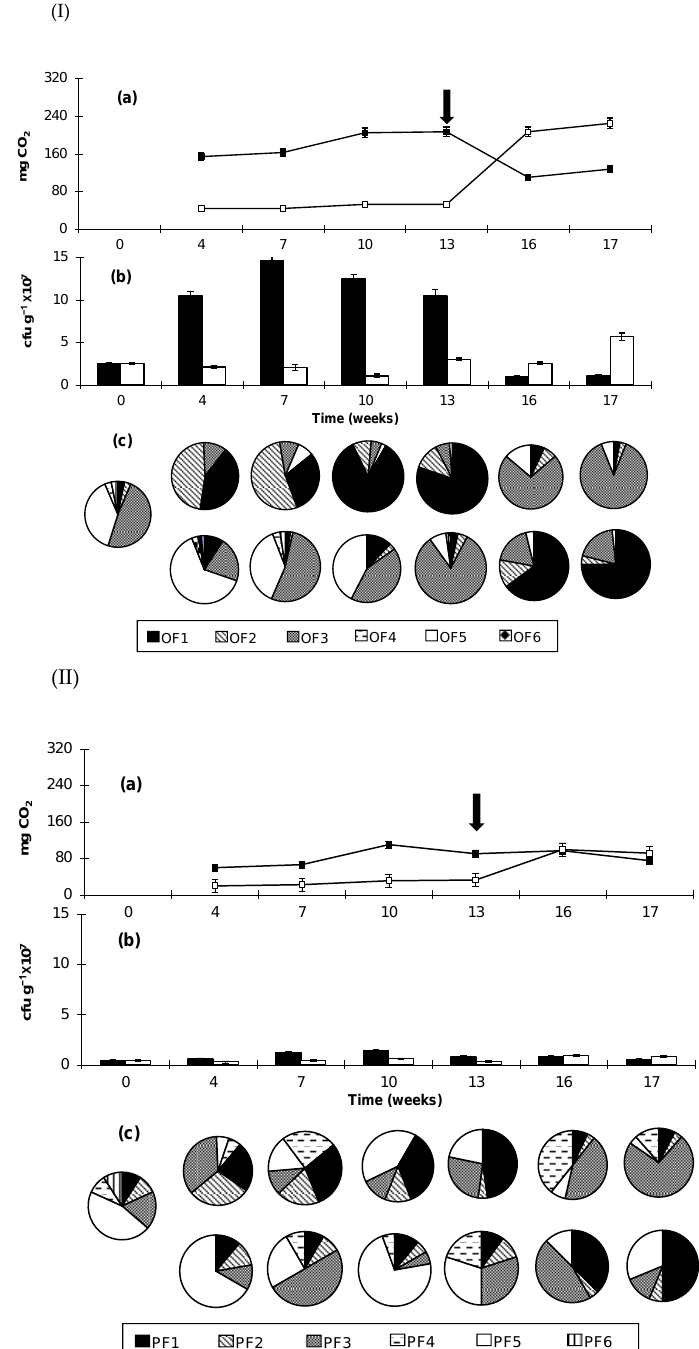
Figure 1. Results regarding ( a ) soil respiration (average ± se), ( b ) abundance of the community of culturable bacteria (average ± se) and ( c ) relative participation of the isolated main bacterial strains in enriched with fenchone (F) and in control soil samples, from ( I ) an oak forest (O) and ( II ) phrygana (P). Fenchone was added every week. Measurements for ( b , c ) were taken at the start of the experiment and on the 4th, 7th, 10th, 13th, 16th, and 17th week; measurements for ( a ) started on the 4th week. At the end of the 13th week, as indicated by an arrow, fenchone addition was reversed: control samples became the enriched ones and vice versa. In ( a , b ), white colour corresponds to control soil samples and grey to enriched ones. In ( c ), the upper row corresponds to treated samples and the lower to control samples. For the bacterial codes, see note 1 under Table 2. The effect of fenchone on these structural features of the soil bacterial communities was readily reversible. When addition of fenchone came to a stop, there was a rapid de- crease in the participation of the highly dominant strains; accordingly, addition of fen- chone to the formerly control samples led to a similarly fast increase of the same strains that were previously dominant in the enriched samples (Figures 1 and S1). Such rapid reverse changes were also recorded for soil respiration and bacterial abundance; they were least pronounced in the case of phrygana (Figure 1II). The overall effect of fenchone, as revealed from this study, on soil microbial communities is visualized in Scheme 1.